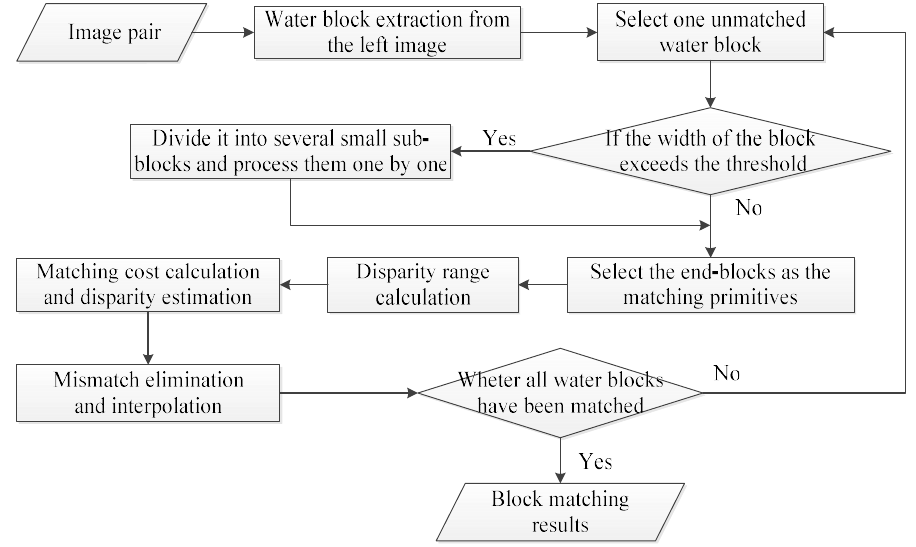
Figure 5. End-block-matching (EBM) strategy.